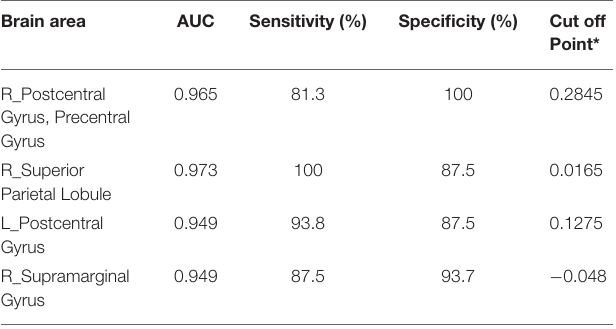
TABLE 4 | ROC curve for the binarized longFCD differences in brain areas between SD and